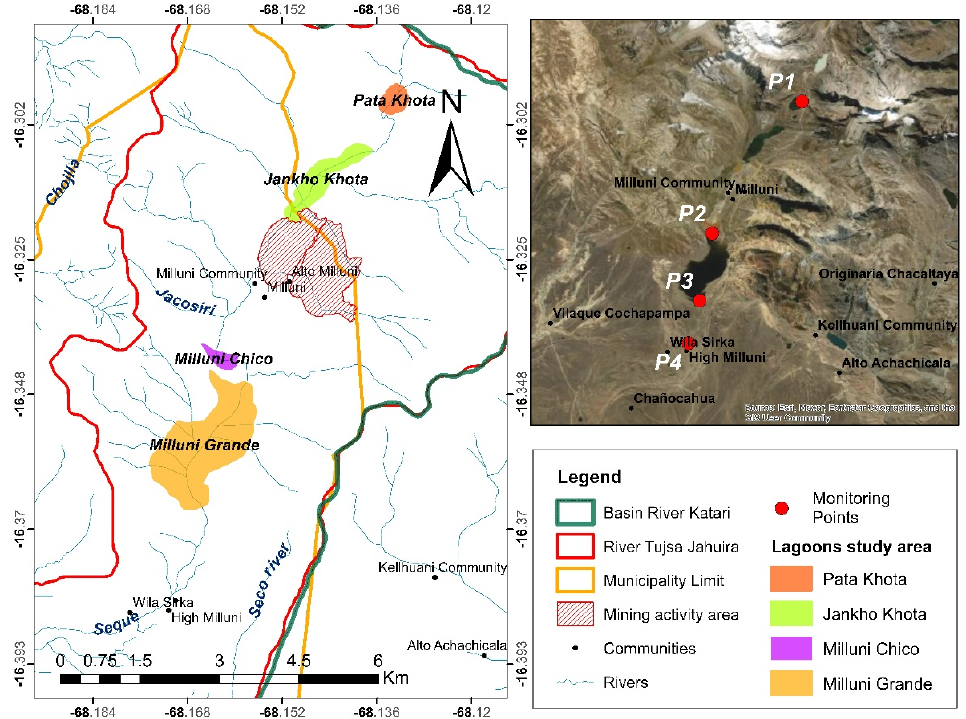
Figure 3. Map of monitoring points in Milluni .